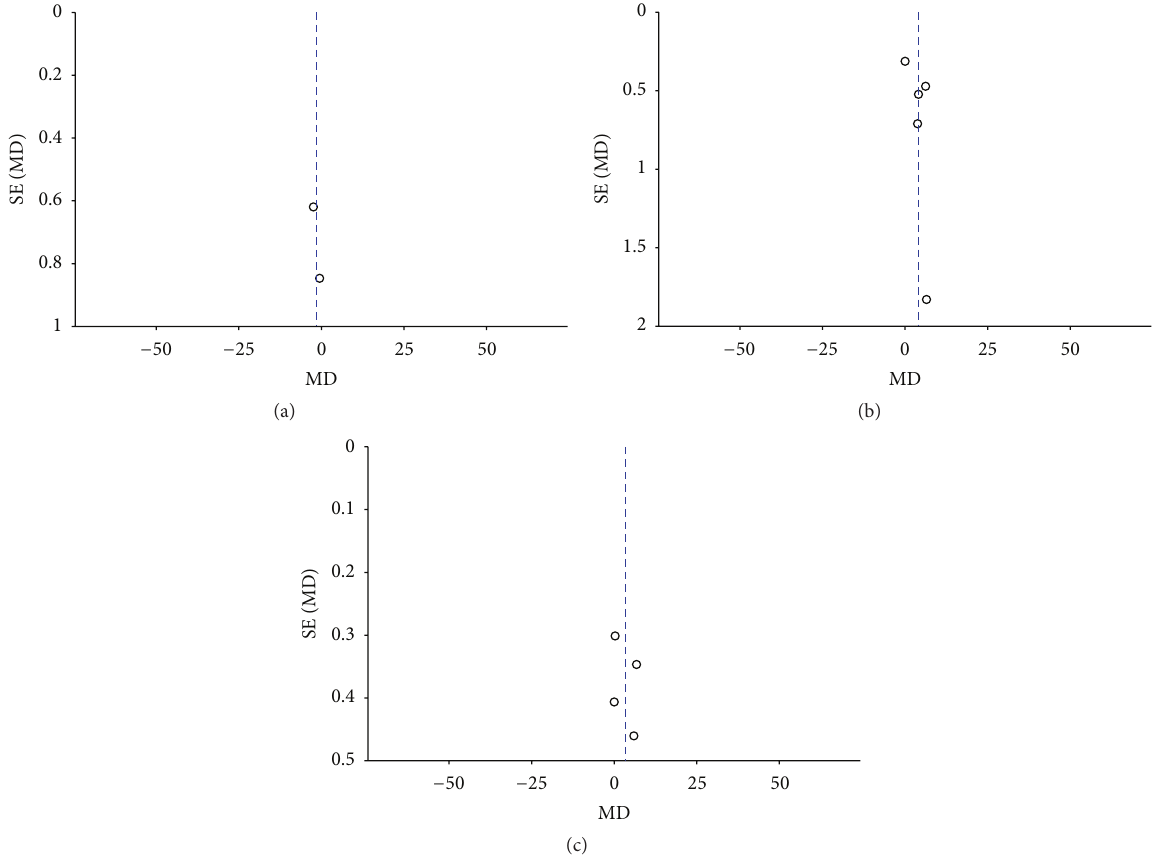
Figure 5: Funnel plot of the change in Schirmer test with (a) and without (b) anesthetics and break-up time